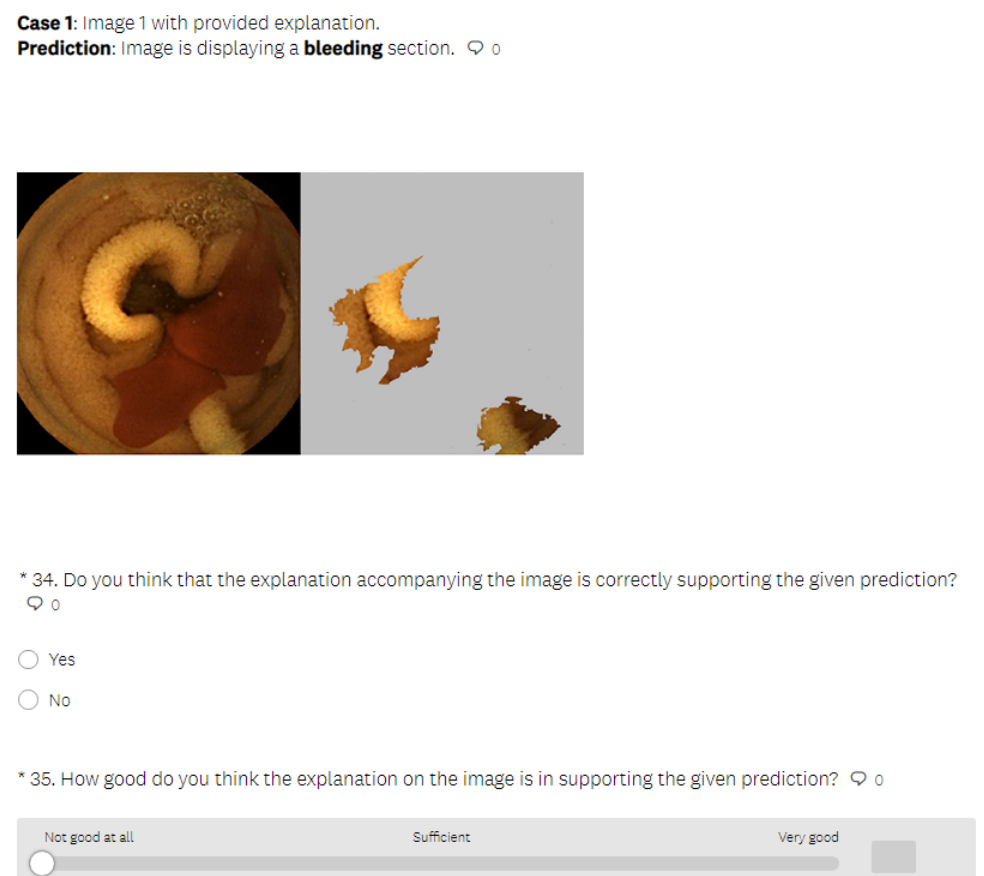
Figure 19. Incorrect CIU explanations in the user